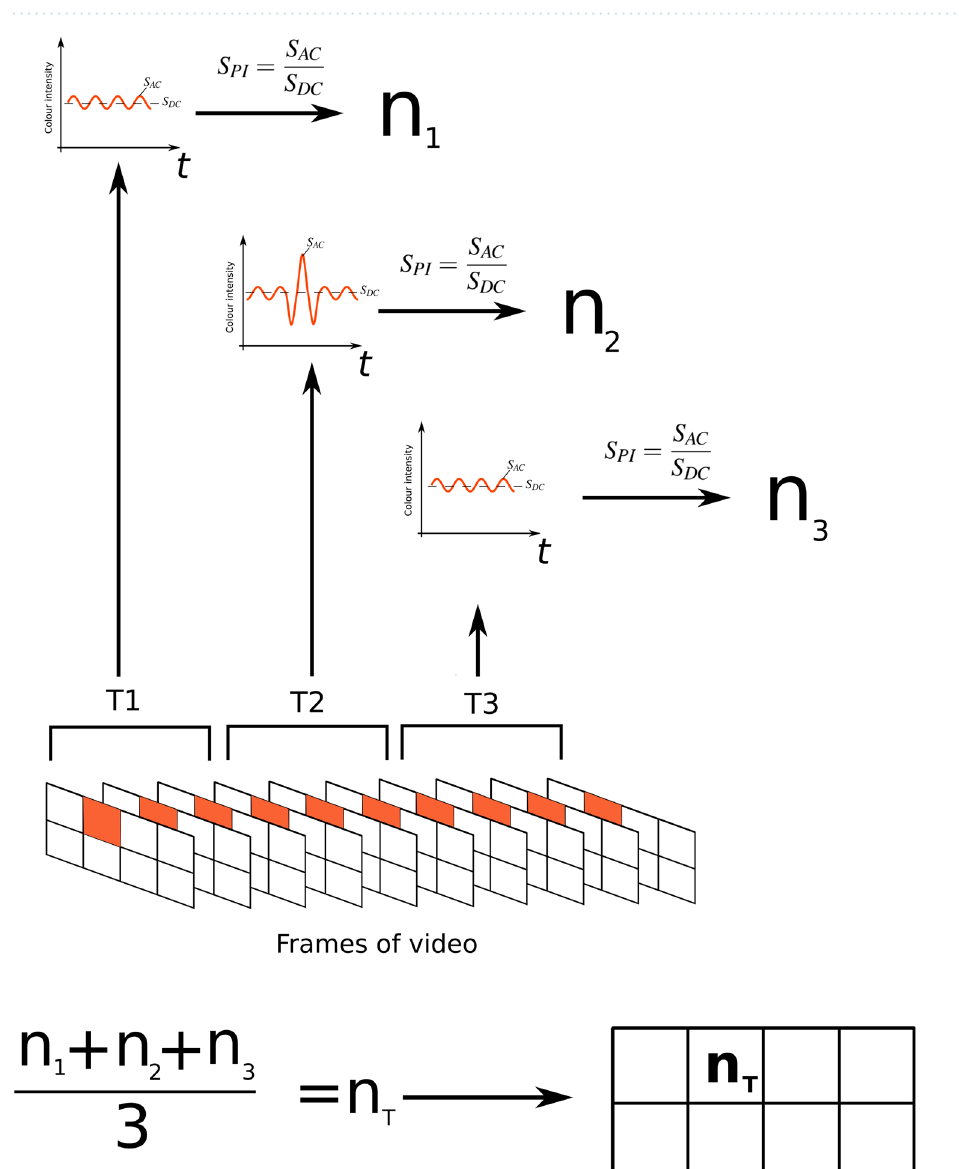
Figure 6. Illustration of the segmental analysis, in this example dividing the video into 3 segments. Each segment is analysed individually and a mean value, n T , calculated in the end. Notice the individual markings of S AC and S DC for each